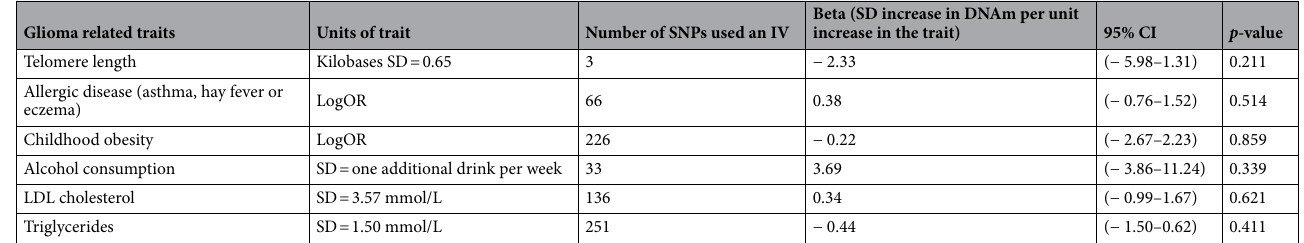
Table 8. The MR effect estimates of the effect of the glioma related trait on CpG methylation. SD standard deviation, 95% CI confidence intervals; p-value for the observed